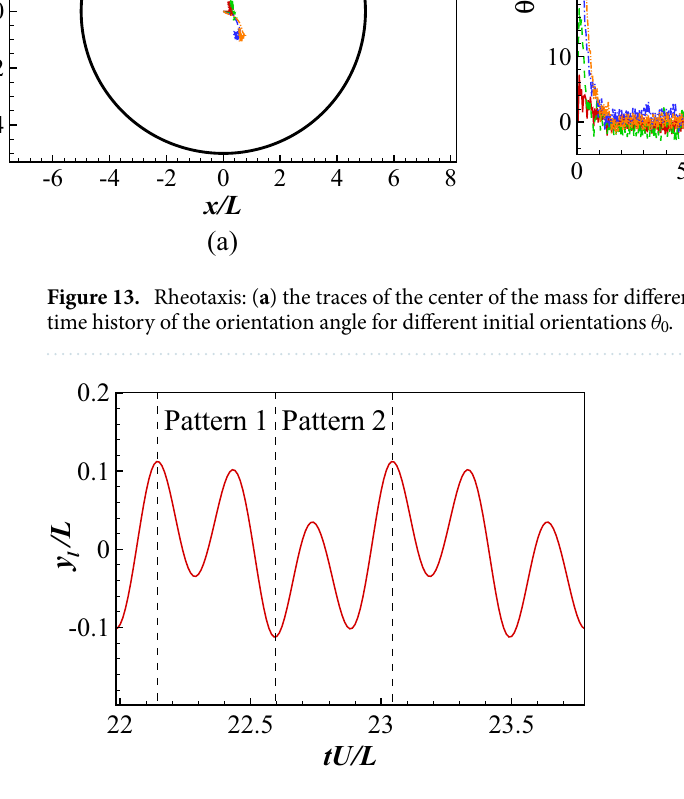
Figure 14. The lateral movement of the tail during rheotaxis.